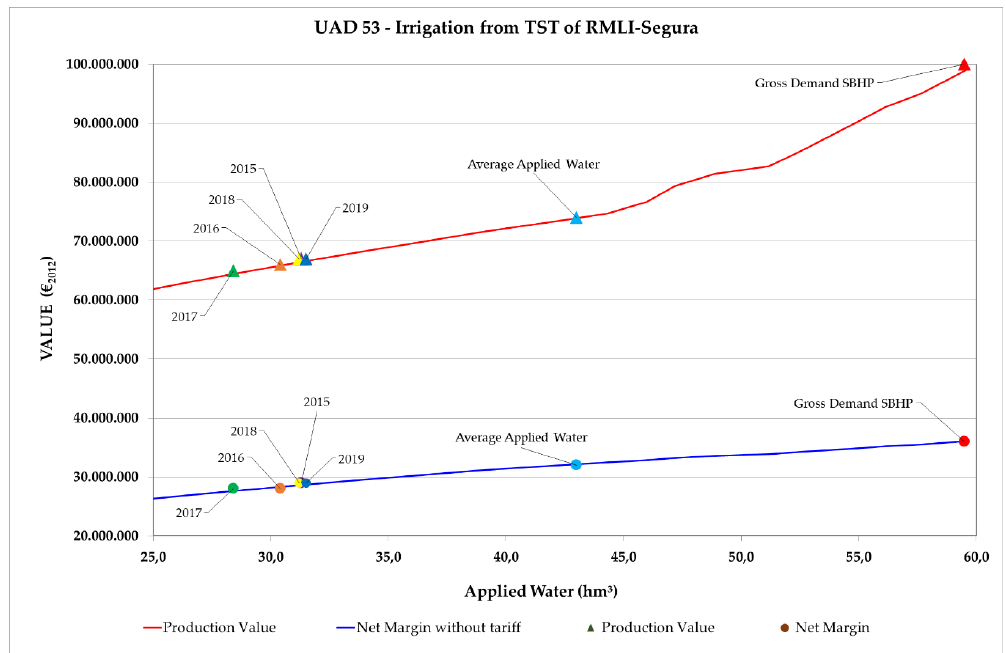
Figure 8. Demand curve and value of production UAD 53, SBHP 2015/21 and annual average. Source: SBHP 2015/21 Own elaboration.